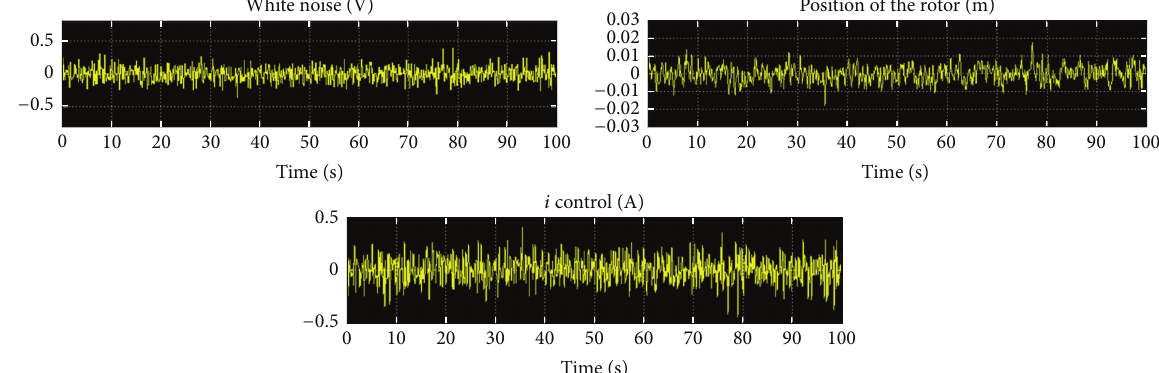
Figure 9: System response with PD controller with proportional gain of 12.2083 and differential gain of 1.9875 and white noise of 0.001 volts.